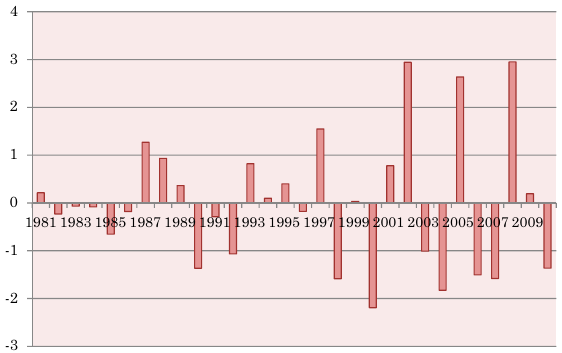
fig. 9. Retail sales receipts as percentage of capital value – deviations from the HP filter trend ( λ =